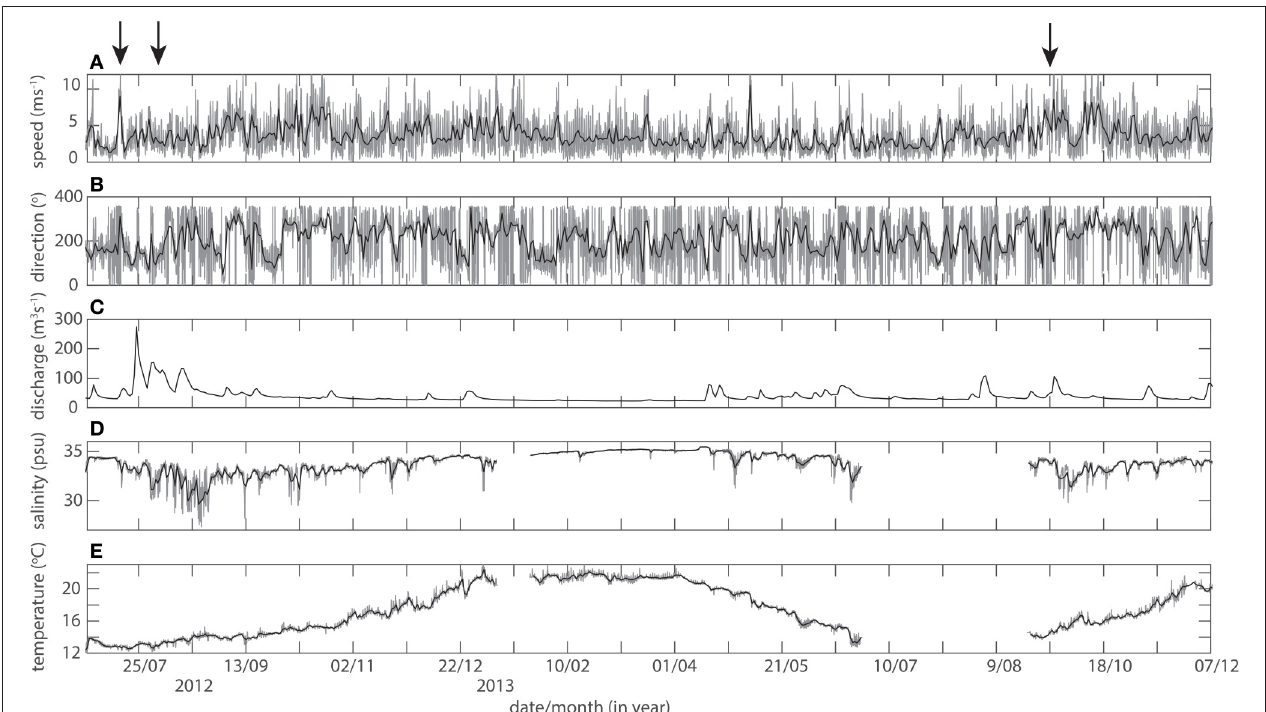
FIGURE 2 | Boundary forcing processes of (A) wind speed, (B) wind direction, and (C) river discharges from the Waihou river (at Tirohia) for July 2012 to December 2013. Observations from the equivalent time periods of near-surface (D) salinity and (E) temperature at WilsonB. The black line overlying all data is the daily mean and corresponds to the sampling interval (daily) of river discharges. Arrows indicate timing of the three discharge